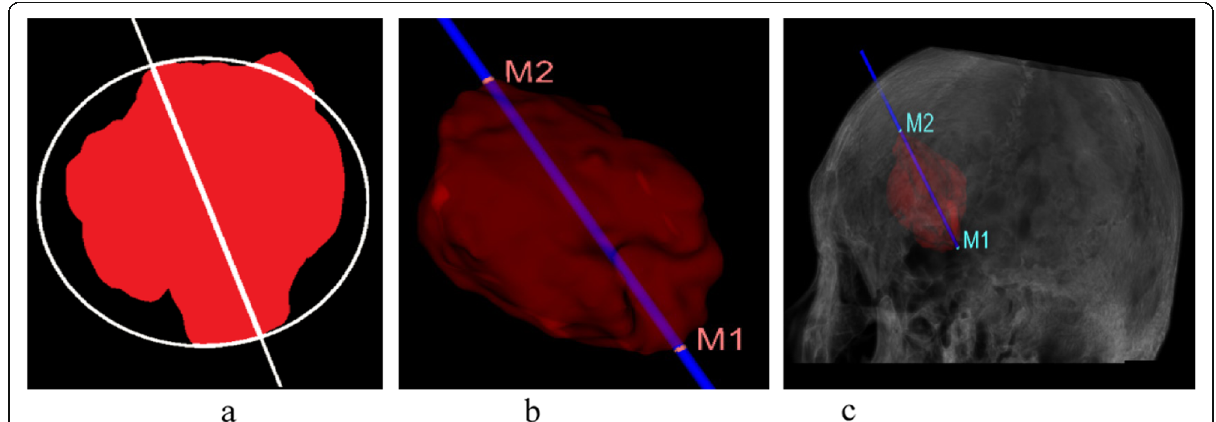
Fig. 8 Optimal external central axis of the hematoma. a Two-dimensional projection; b Three-dimensional projection; and c The exact position in